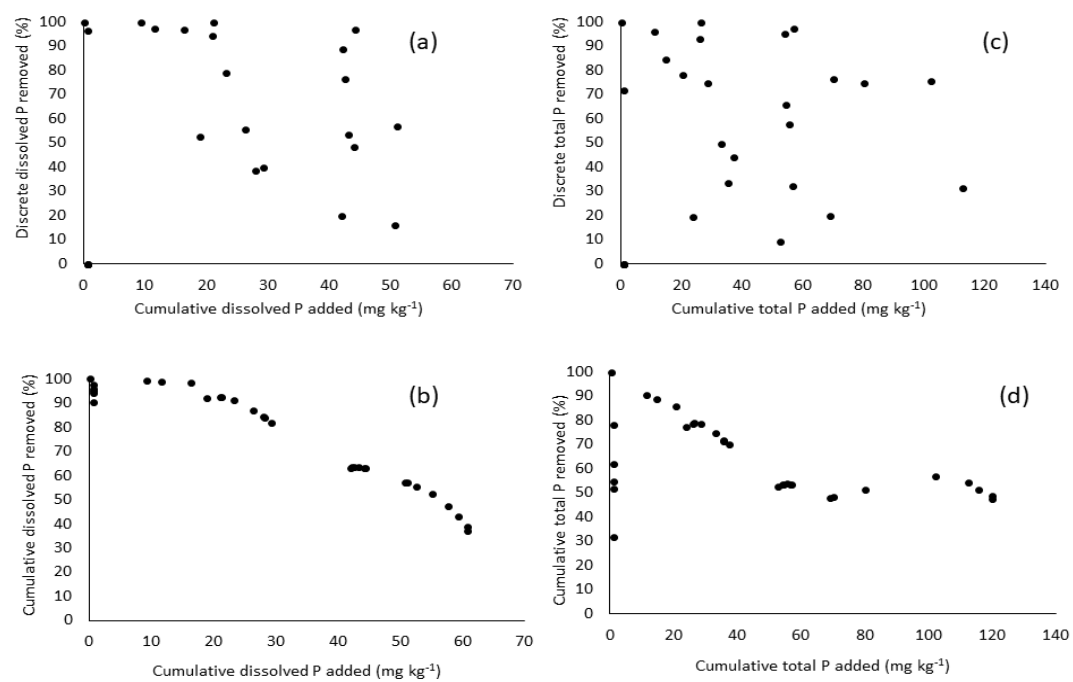
Figure 6. Discrete and cumulative dissolved and total phosphorus (P) removal for the ditch P removal structure, shown as a function of cumulative P loading to the structure. Discrete dissolved and total P removal ( a and c ) are shown excluding negative values in order to improve clarity, but cumulative dissolved and total P removal ( b and d ) are calculated with inclusion of those negative values. Note that the horizontal axes scales for ( a ) and ( b ) are different from ( c ) and ( d ).